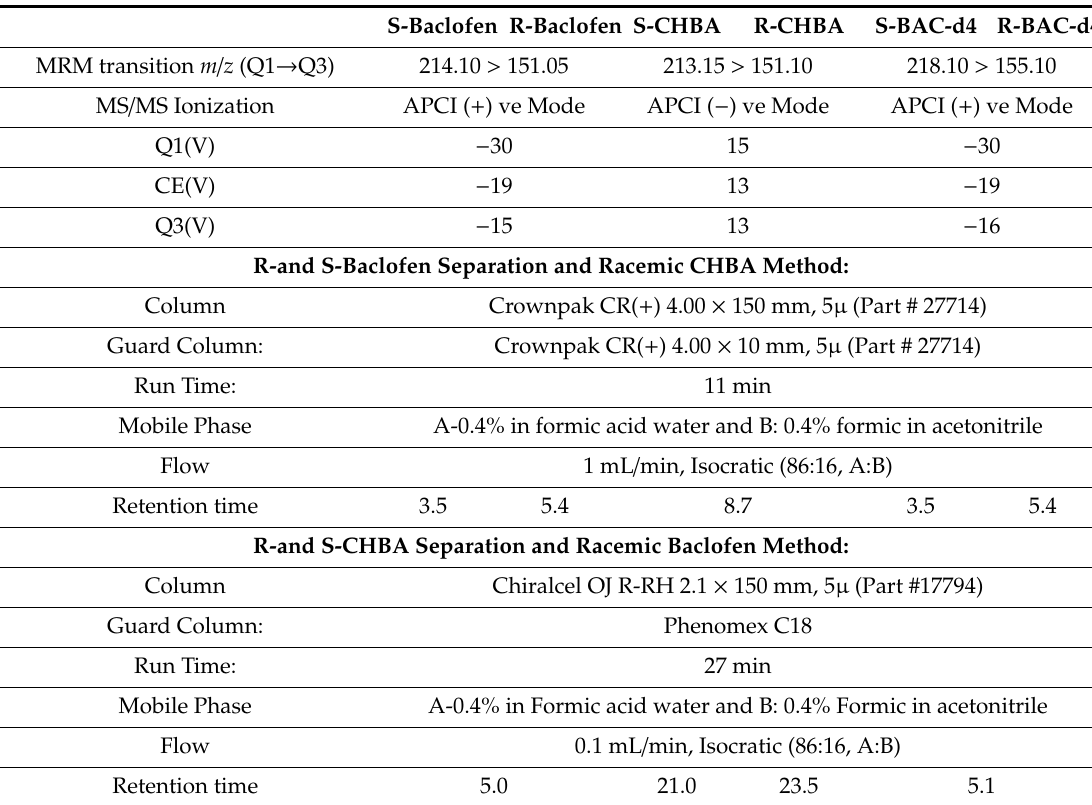
Table 1. Summary of MS / MS and chromatography parameters for both methods. APCI: atmospheric pressure chemical ionization, MRM: multiple reaction